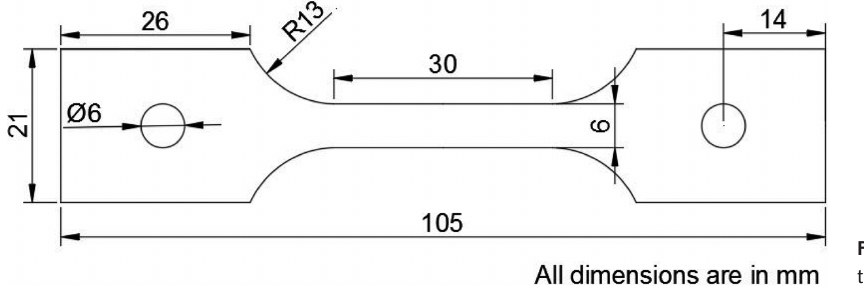
Figure 1: The dimension of the uniaxial tensile